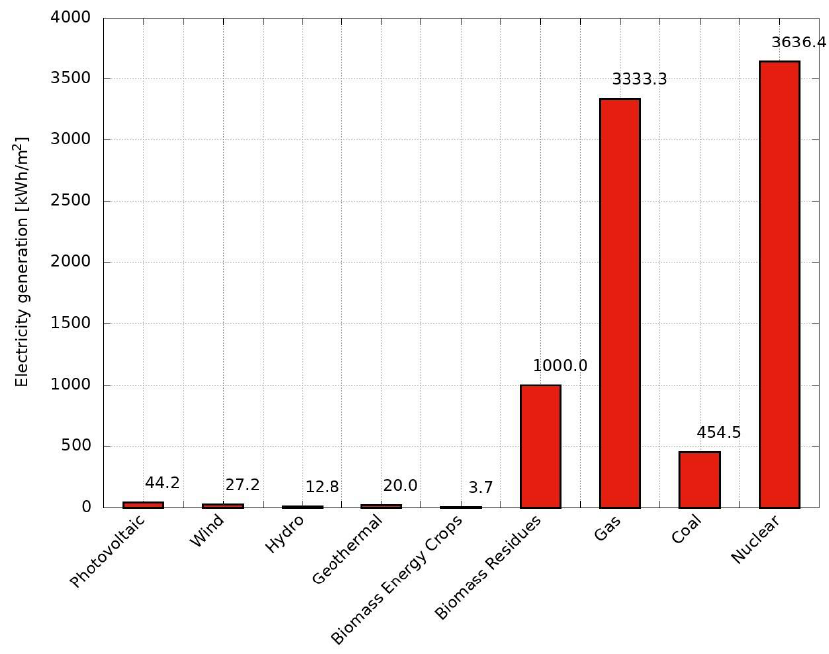
Figure 17. Electricity generation per square meter of land occupied (own analysis from [28,31–33]).